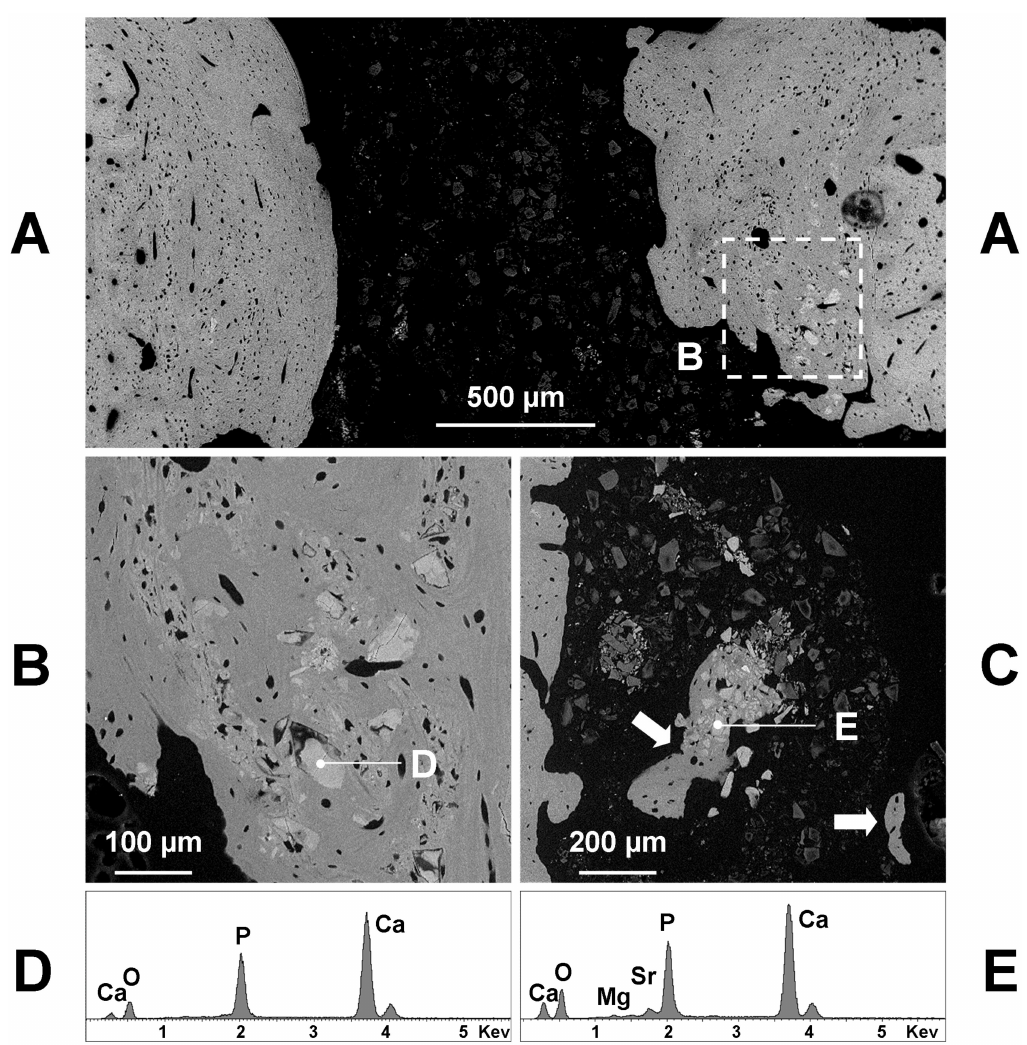
Figure 5. Representative backscattered SEM images of a transverse section taken at the central part of a BGMgSr filled hole, 60 days after the surgery. The B boxed area of A correspond to the remodeled bone ( B ) at a greater magnification. The newly formed bone (darker in A ) contains several irregularly shaped osteocytes ( B ) and includes some granules ( D ) consisting of calcium phosphate, as shown by the X-ray microanalysis ( D ). Few isolated bone formations (arrows in C ) of the medullar cavity are surrounded by remnants of the implanted glass ( C ), sometimes contain mineral granules ( E , lighter in C ) consisting of calcium phosphate with amounts of strontium and magnesium, as shown by the X-ray microanalysis ( E